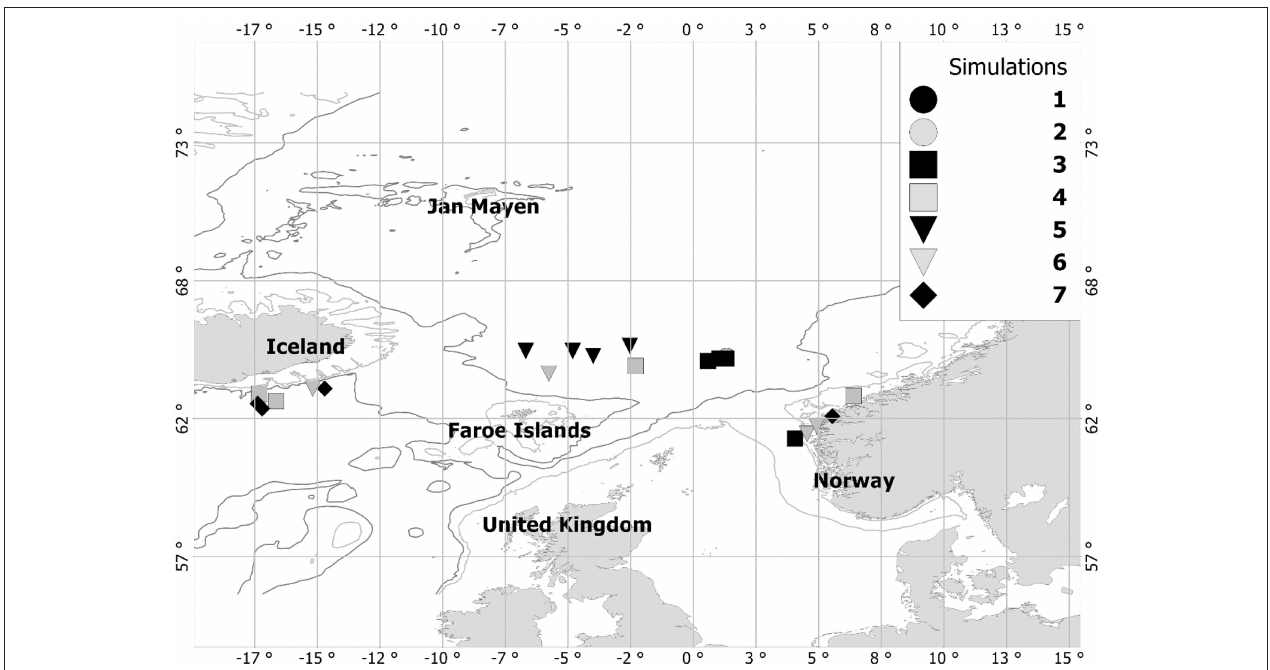
FIGURE 2 | The average center of mass at the end of the year in the 30 last years in all four replicates of the simulations. The contours give the 200 and 500m depth. Note that simulation 1 and 2 are in the same location centrally in the Norwegian Sea, hidden behind the two black squares (simulation 3).